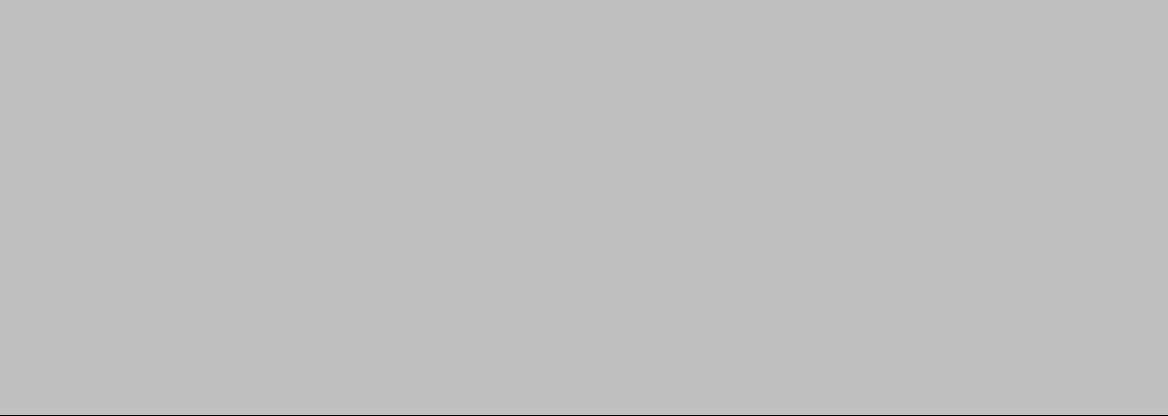
N = Nulliparous; P = Parous; ?=data reported as percentages shown; numerators cannot be ascertained exactly * All episiotomies are mediolateral, except those in Klein et al. (50), which are all midline. @ Third and fourth degree spontaneous tears and extensions of